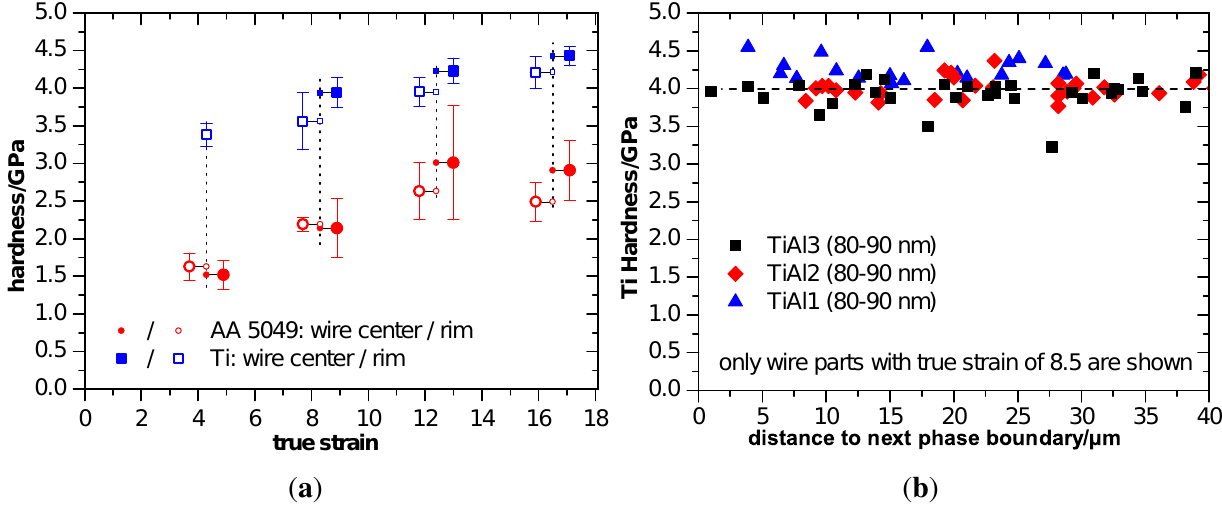
Figure 3. Hardness of ( a ) the Ti and AA5049 parts of the wires strained to different strain levels. Open symbols show hardness near the wire rim, while filled symbols correspond to the wire center region. ( b ) The hardness of Ti bridges deformed to a true strain of 8.5; no phase boundary effect within Ti is visible. Filled and open symbols are shifted manually to different values for clarity reasons. Each of them correspond to the true strain values of 4.3, 8.5, 12.6 and 16.8,